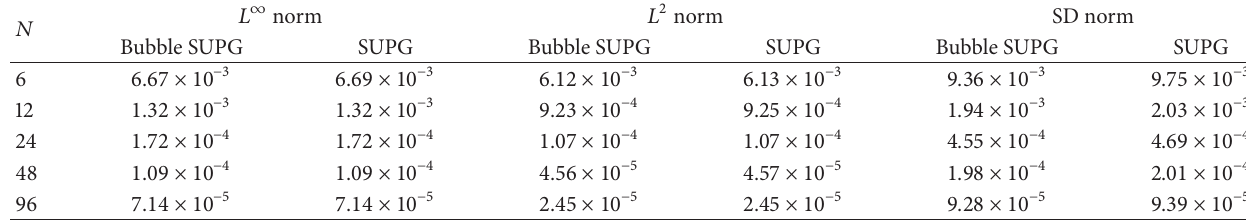
Table 8: 𝜀 = 10 −2 , Problem 2 (comparison of convergence rate).